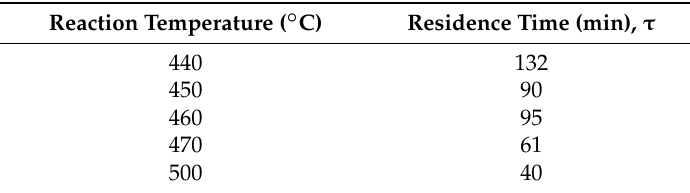
Table 1. Effect of reaction temperature on LDPE pyrolysis